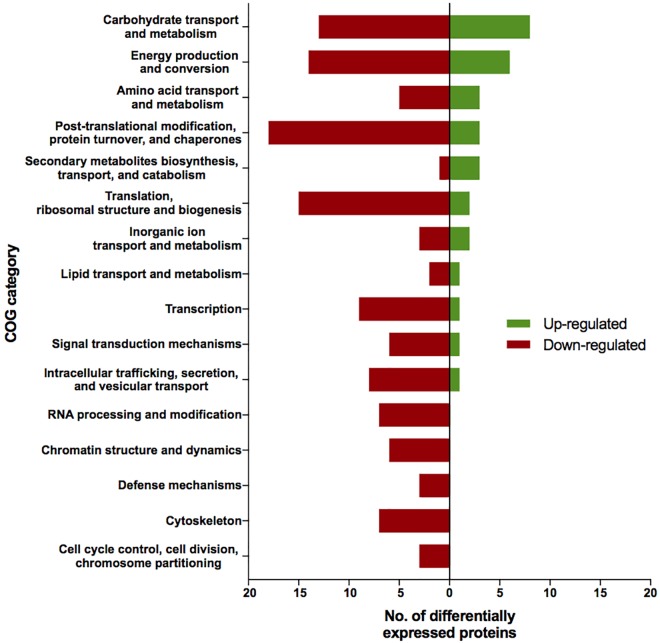
Biological process COG categories of differentially expressed proteins in IMV 00236-30. Differentially abundant proteins (FC > |2|, P < 0.05) were mapped to terms representing various biological processes using cluster of orthologous genes (COG) database in CloVR.